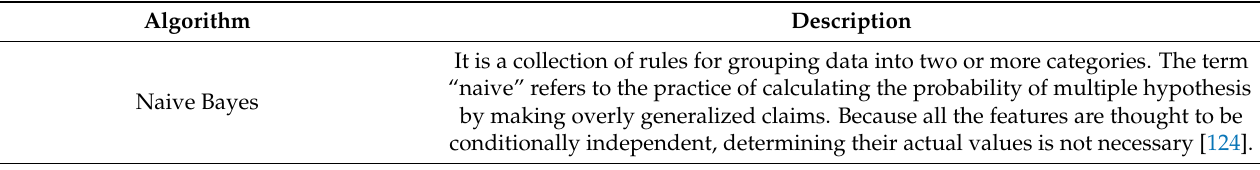
Table 13. Summary of deep learning and machine learning algorithms